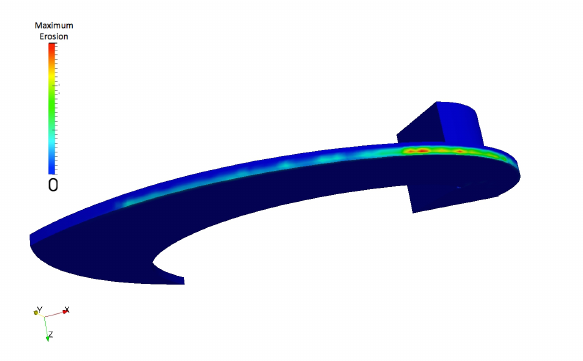
Figure 6: Nandakumar’s model calculated